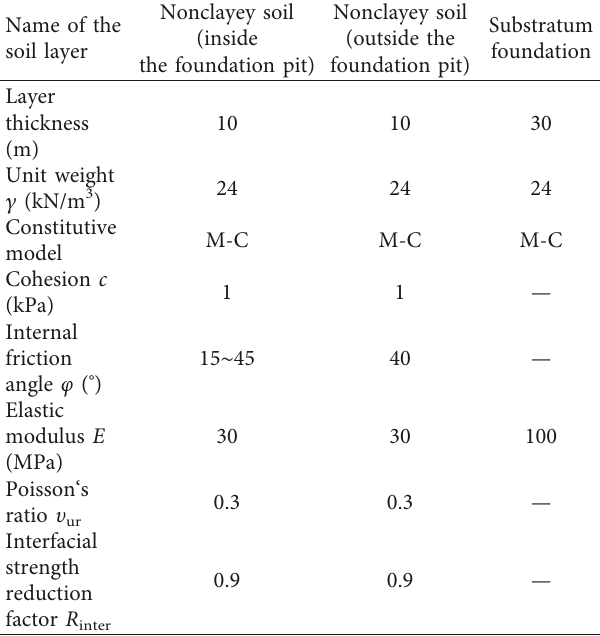
Table 6: Physical and mechanical parameters of the model soil.